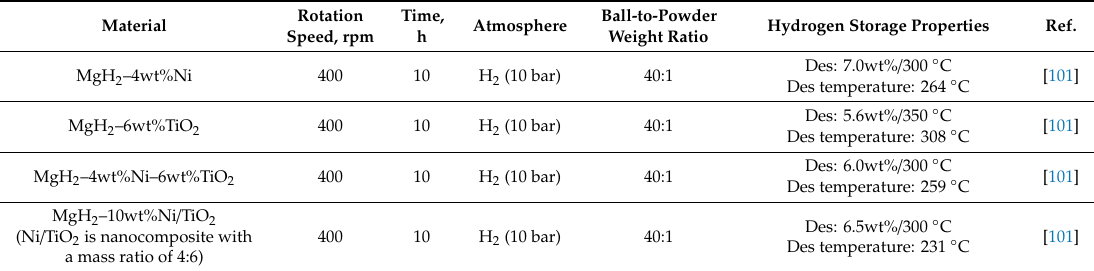
Table 3. Hydrogen storage properties of selected Mg modified by metal oxide additives.